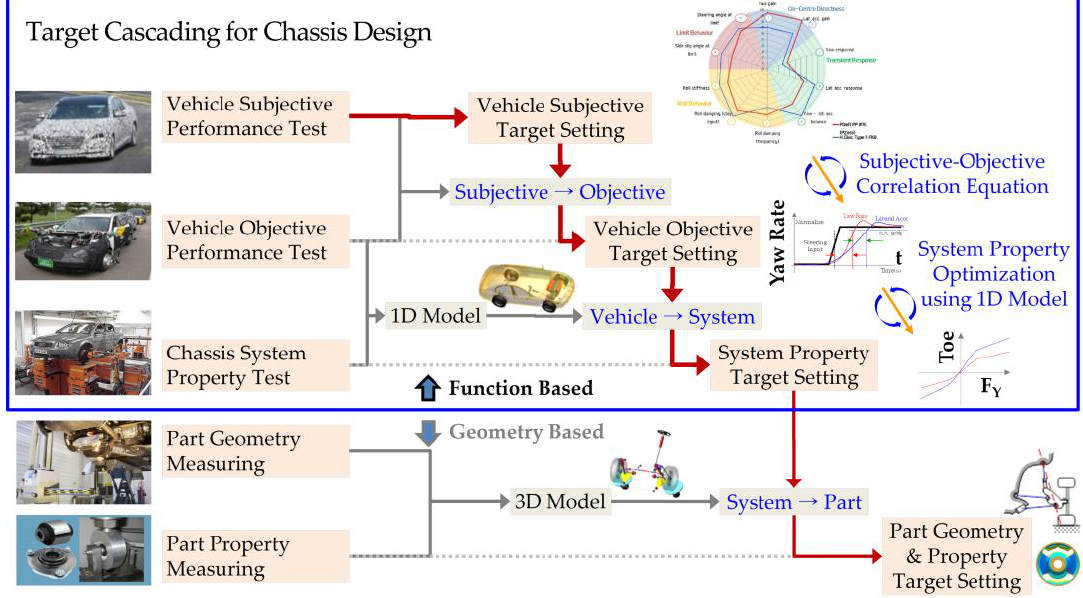
Figure 1. Optimal setting of model-based design factors before design.